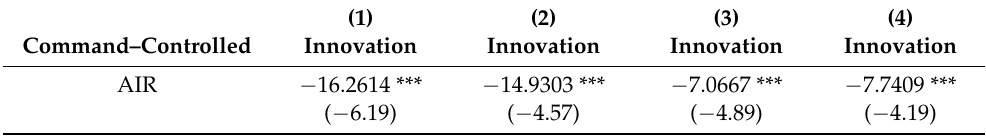
Table 11. DID regression results of command-controlled environmental